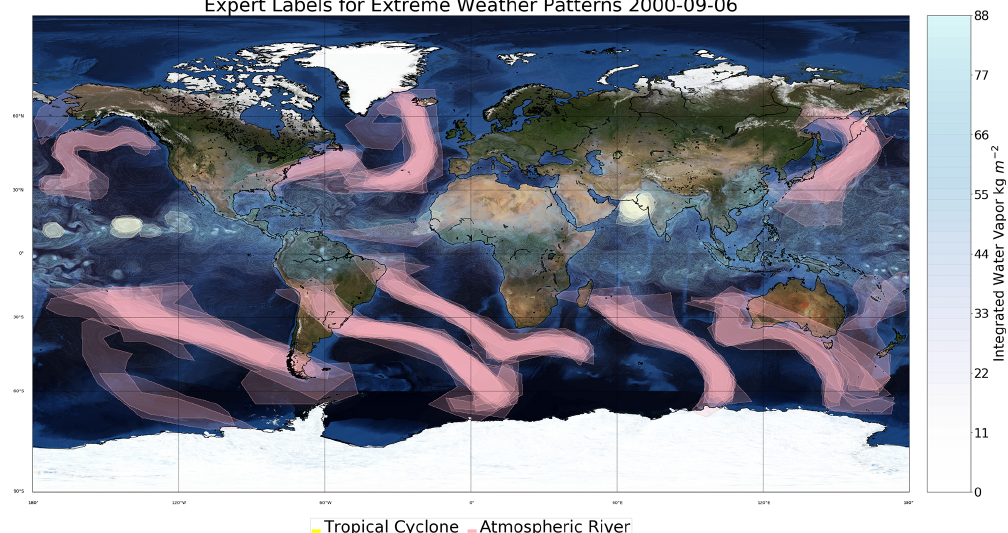
Figure 2. Comparison of 15 different expert labelings. Density of pink masks shows overlap of AR labels; density of white/yellow masks shows overlap of TC labels. The “bluemarble” map in the background included via Matplotlib’s Basemap library is ©